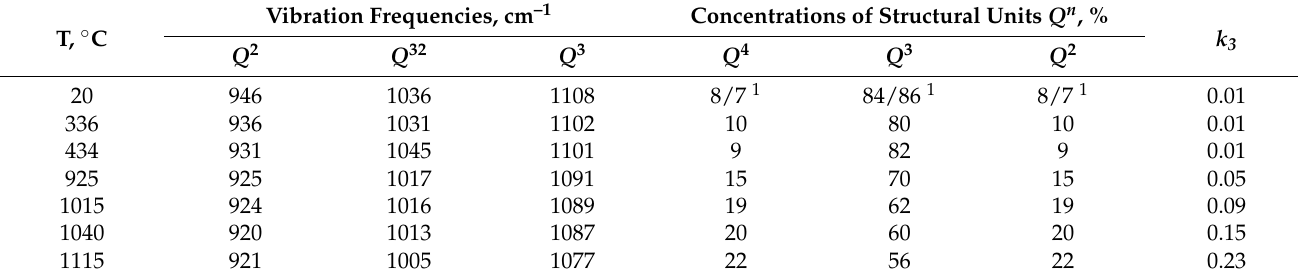
Table 1. Vibration frequencies, concentrations of structural units and equilibrium constants of Reaction (1) at n = 3 in glasses and melts of the potassium silicate sample with 33 mole per cent of potassium oxide at various temperatures ( 1 -NMR data [34]).